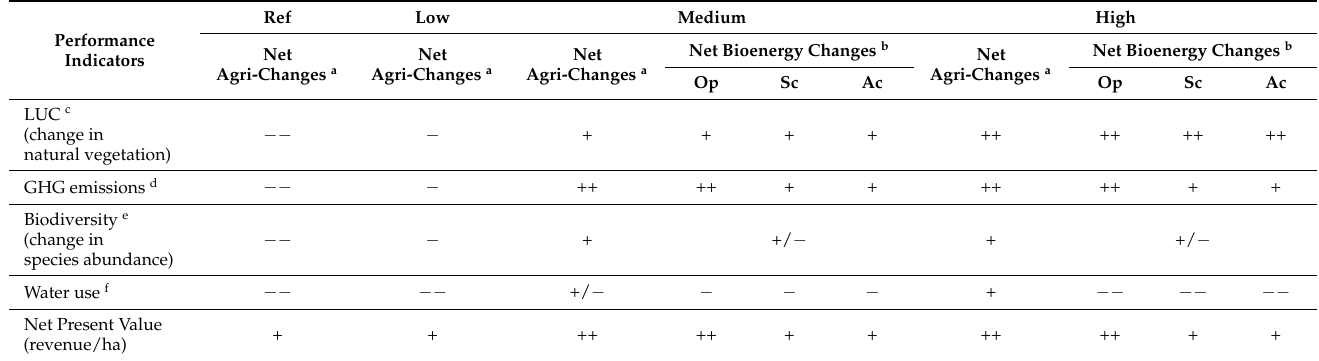
Table 2. Key impacts of agricultural intensification and bioenergy production in 2030 for 4 scenarios compared to 2018 for the Orinoquia region. Op—oil palm, Sc—sugarcane and AC—acacia